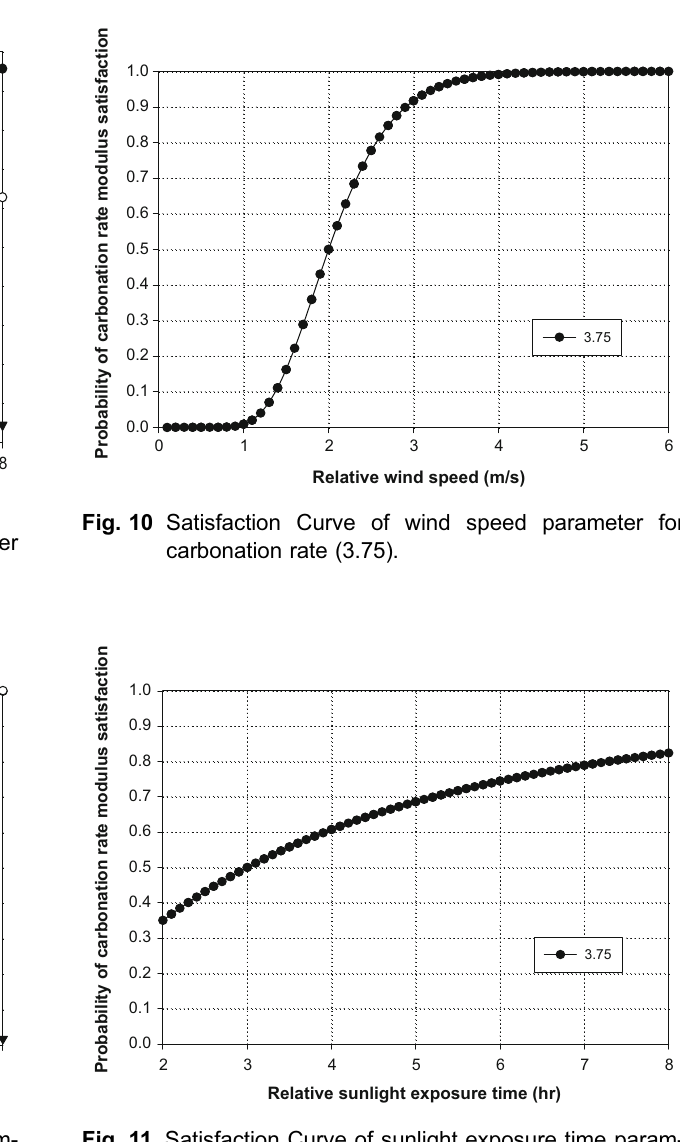
Fig. 8 Satisfaction curve of wind speed parameter for com- bine carbonation rate (3.5, 4.0, 4.5).